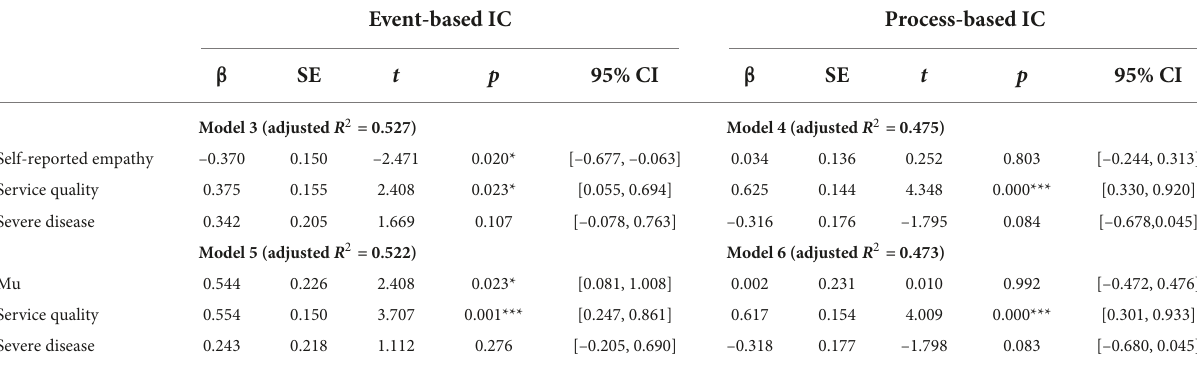
TABLE 3 Standardized coefficients of regression models comparing the effects of empathy under event-based and process-based